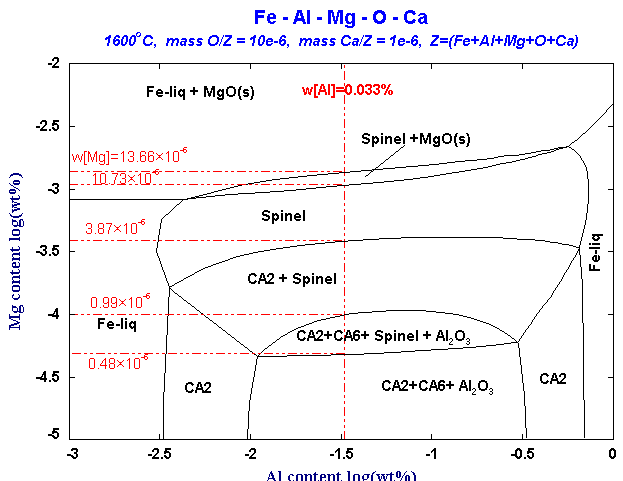
Figure 6. Phase diagram of inclusions in Fe-Al-Mg-O system with [O] = 10 ppm and [Ca] = 1 ppm at 1600 °C.